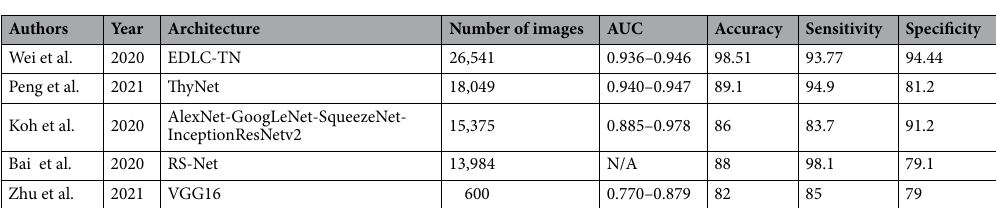
Table 3. Summary of recent studies on the thyroid ultrasound image analysis using neural